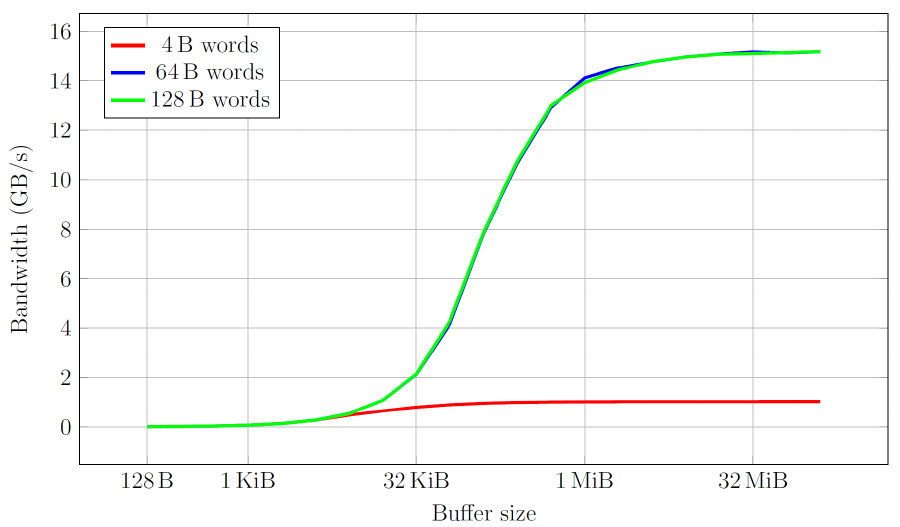
Figure 4. Bandwidth for various buffer sizes and data